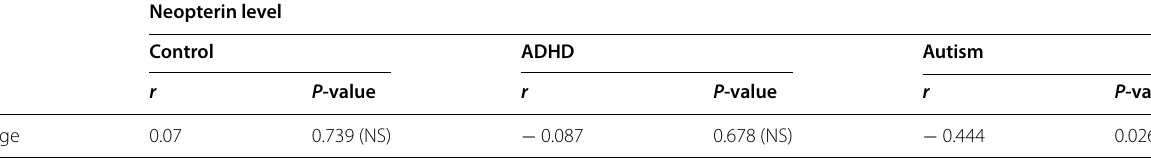
Table 6 Correlation between neopterin level and